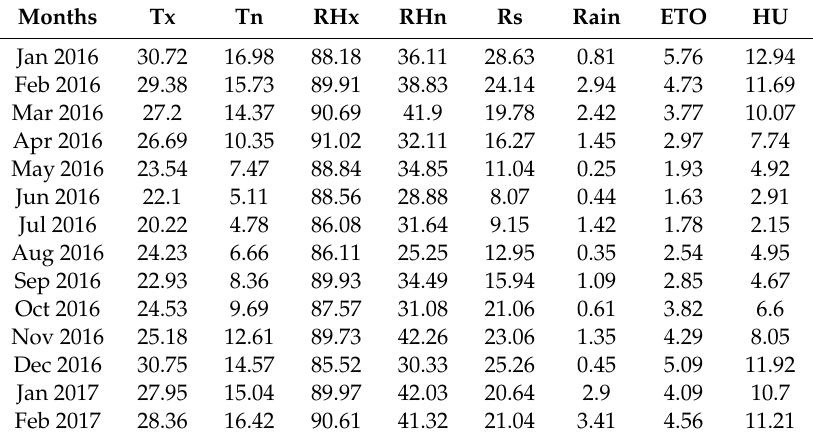
Table 2. Summary of weather elements during the growing period at the UFH research farm. Months